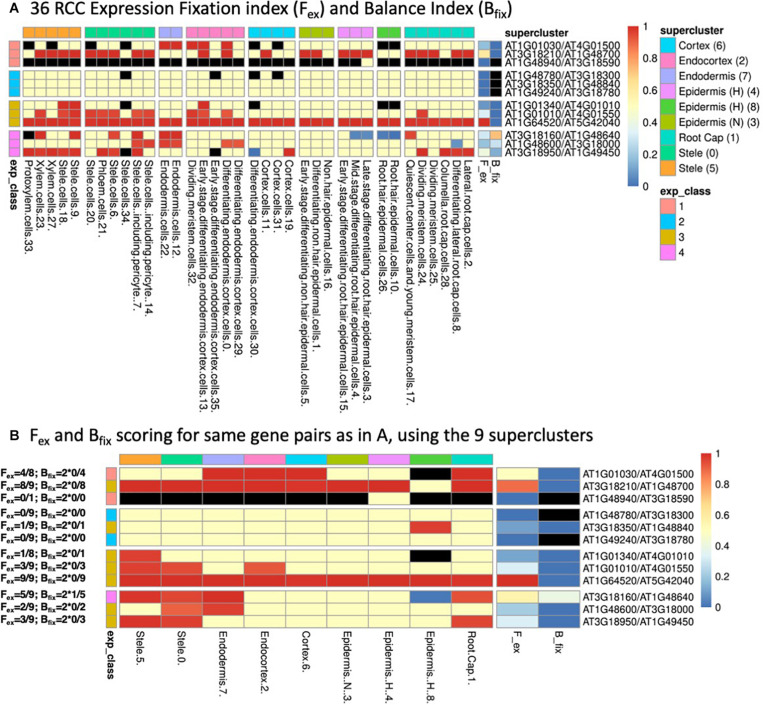
(A) Heatmap of 36 root cell clusters (RCCs) from nine Ryu et al. (2019) superclusters, showing examples of selected gene pairs illustrating Fex and Bfix (last two columns before gene pair designations) and the four expression classes (defined in Table 1). Cell colors: for RCCs, red cells have dominant paralog scA fixed (expressed above the 9:1 threshold at 95% confidence level, or, in the case of Class 1, expressed at 1:0); blue cells have paralog scB fixed; yellow cells have at least one of the paralogs expressed, but do not meet the statistical criterion for biased expression; black cells have no expression of either paralog. For Fex and Bfix the cell values for each index run from 0–1 and are colored continuously from blue to red as indicated by the scale at the right of the figure. RCCs are grouped according to the superclusters from which they were derived (as indicated by column heading colors), while gene pairs are grouped according to their expression classes (as indicated by row heading colors). (B) Corresponding heatmap of the same gene pairs as shown in (A) using the nine Ryu et al. (2019) superclusters as the basis for assessment of expression bias. Expression class colors are as in (A). Examples of the calculation of Fex and Bfix values for each gene pair based on the expression-biased contexts detected in each case are given to the left of the figure.